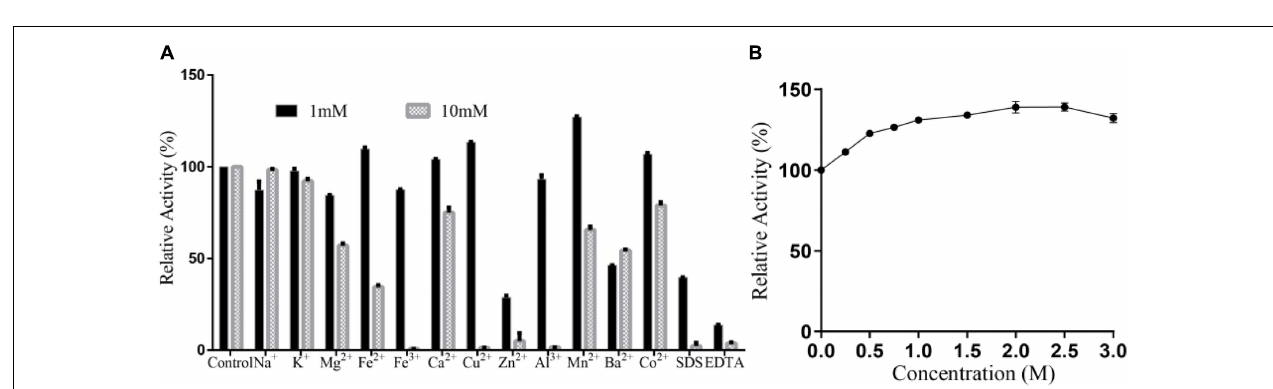
FIGURE 7 | (A) Effects of ions on Alyw203. (B) Effects of NaCl on Alyw203. Values are expressed as mean ± SD, n = 3.